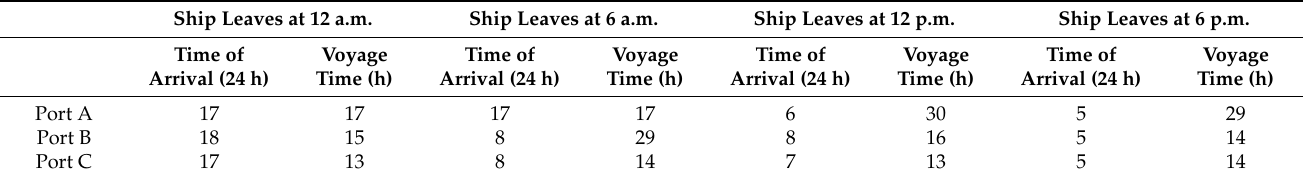
Table 6. Sailing optimization analysis of ships with different departure times *.